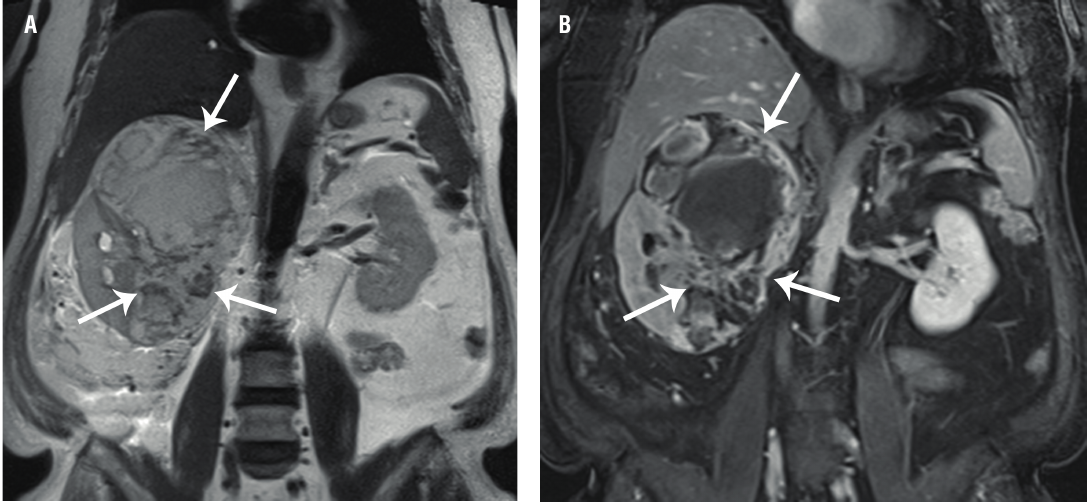
Figure 2 - Coronal T2-weighted (A) and fat-suppressed contrast-enhanced T1-weighted (B) MR images demonstrating a tangled mesh of signal-void tumor vessels (arrows in A) in the periphery of the mass, corresponding to the areas with strong enhancement (arrows in B).